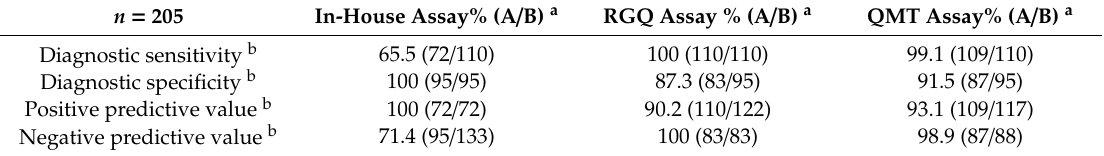
Table 6. Diagnostic performance of in-house, RGQ, and QMT assays with various clinical